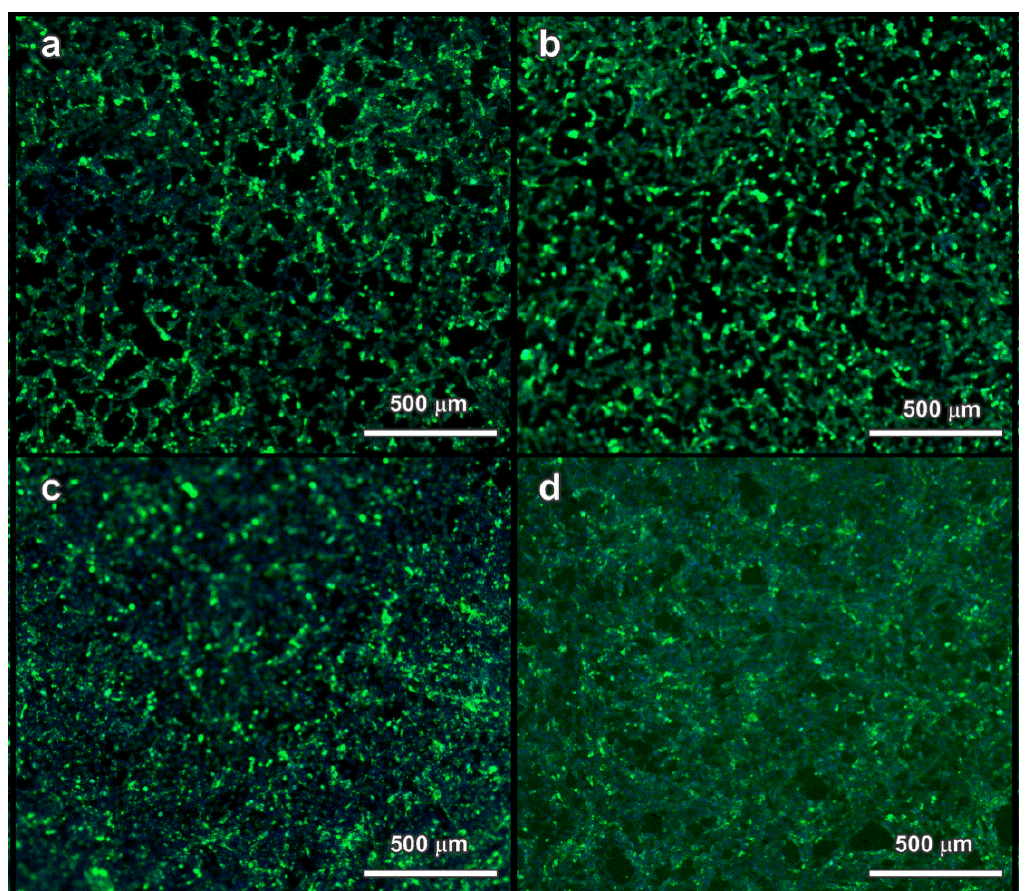
Figure 7. Fluorescence microscope images of samples from direct test method ( a ) 25 wt% S1 900 °C; ( b ) 25 wt% S2 900 °C; ( c ) 25 wt% S1 1000 °C; ( d ) soda-lime glass (reference) (with superposition nucleus (blue) and cell body